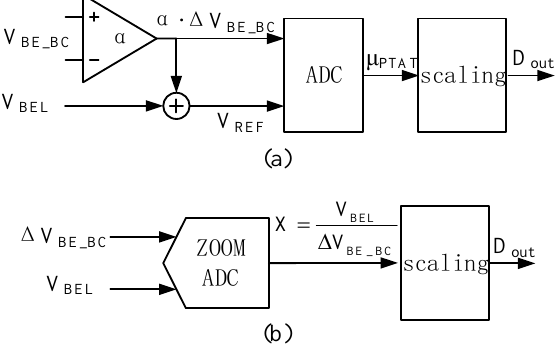
Figure 2. Operating principles of analog-to-digital converters (ADCs): ( a ) sigma-delta ADC; ( b ) zoom ADC.